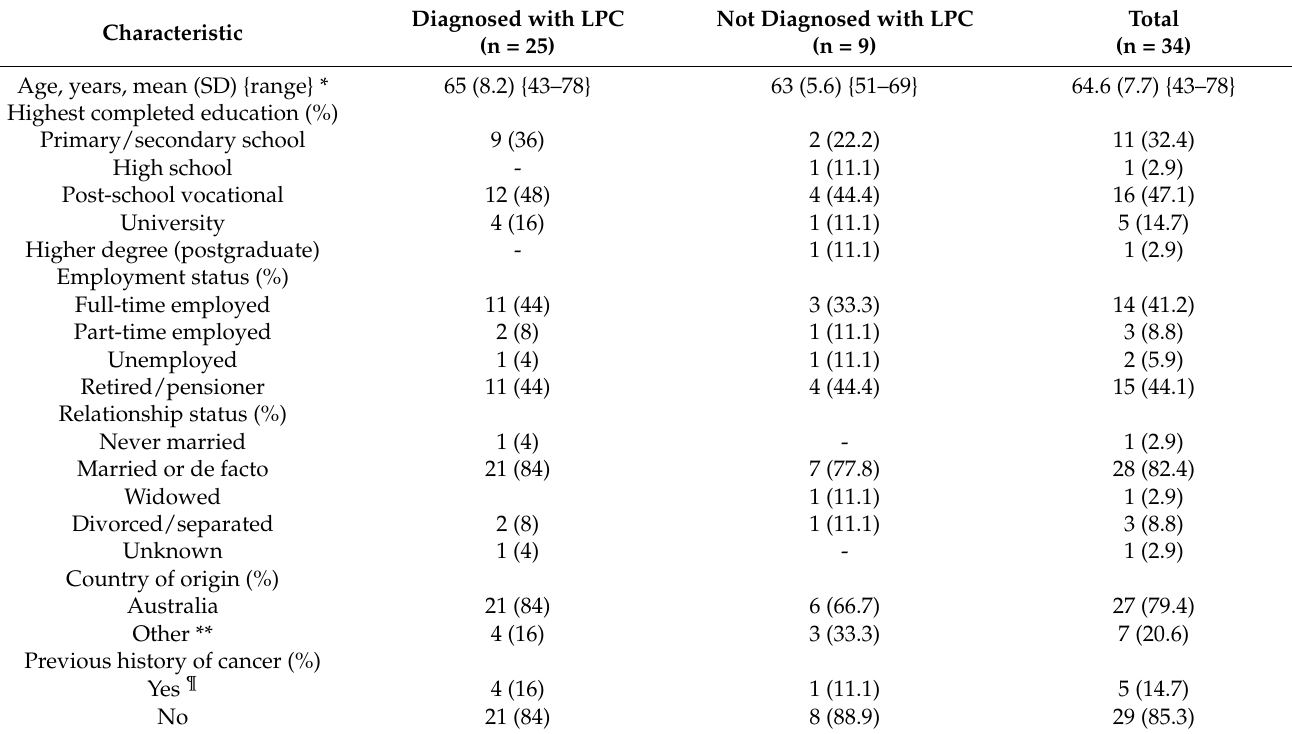
Table 1. Participant demographic